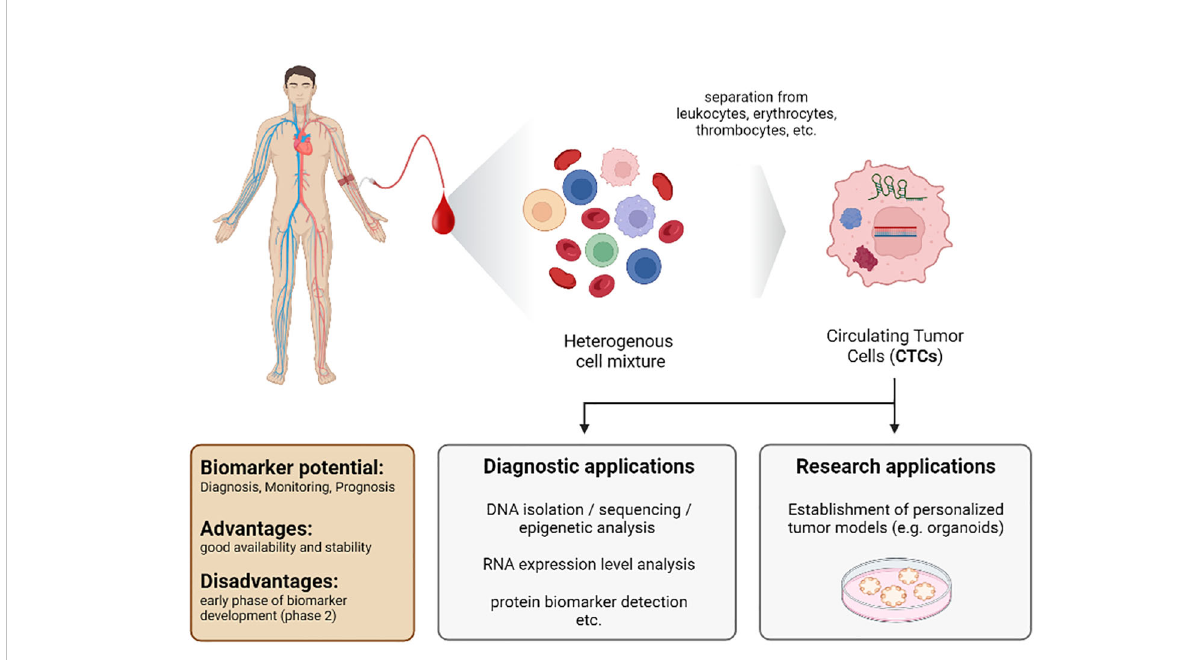
FIGURE 6 Characteristics of the biomarker class circulating tumor cells (CTCs) from a liquid biopsy in patients with